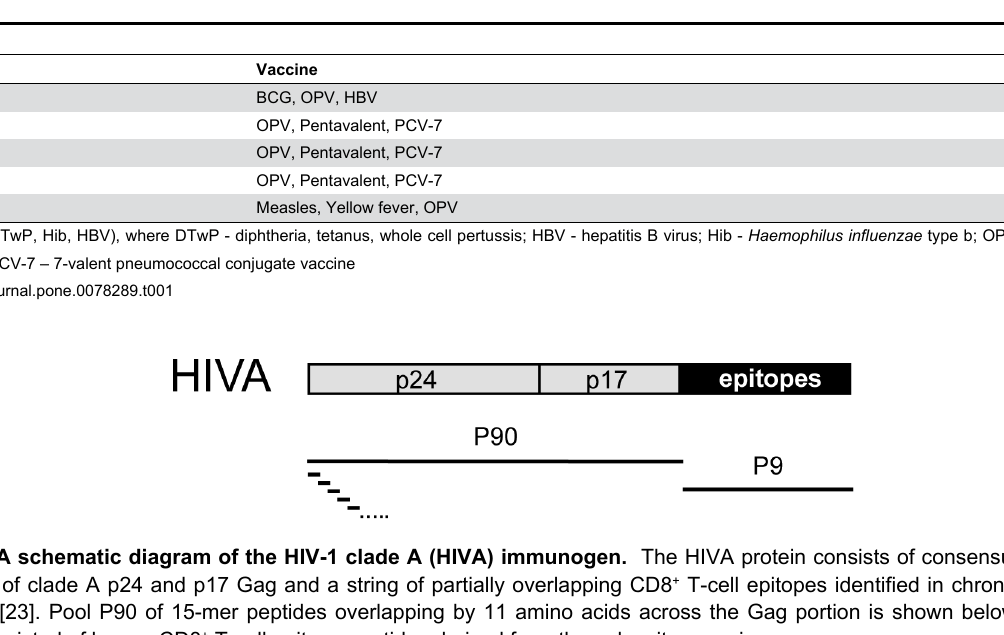
Table 1. EPI vaccination schedule in The Gambia.